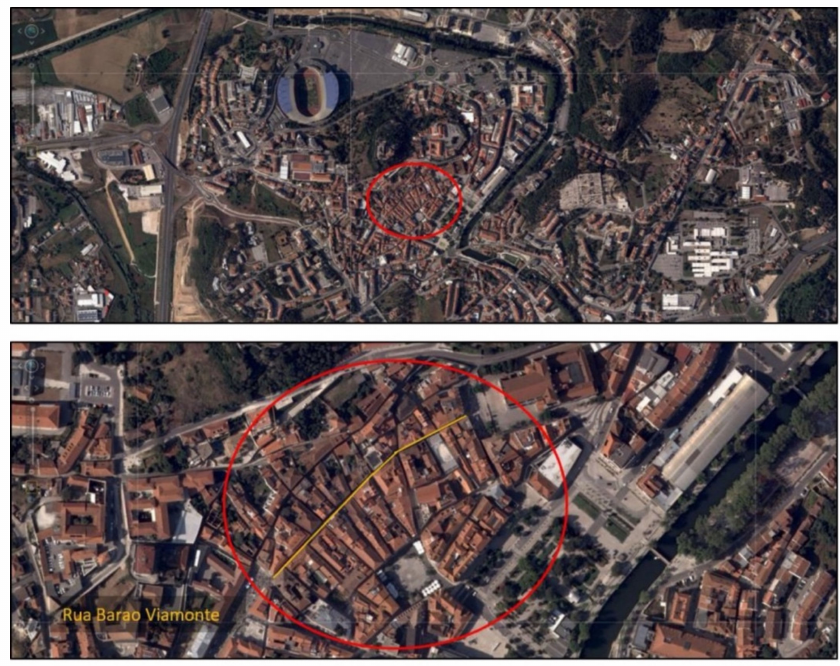
Figure 3. Satellite view of the City of Leiria ( top ); view of the Historic Centre, including the area of study ( bottom ). Google Maps and GeoPortal.